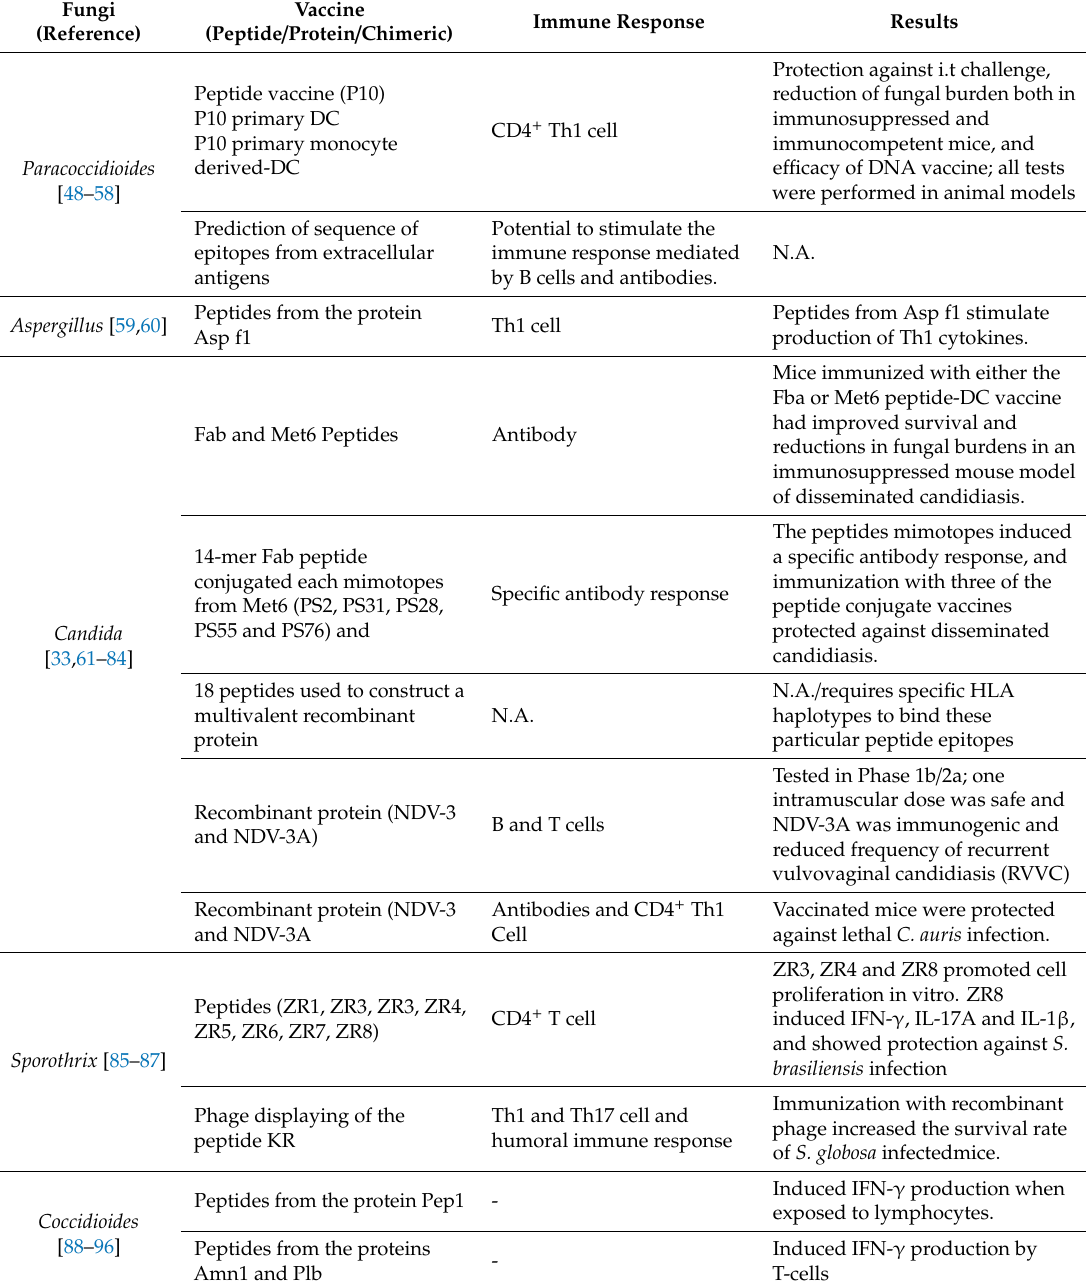
Table 1. New vaccine